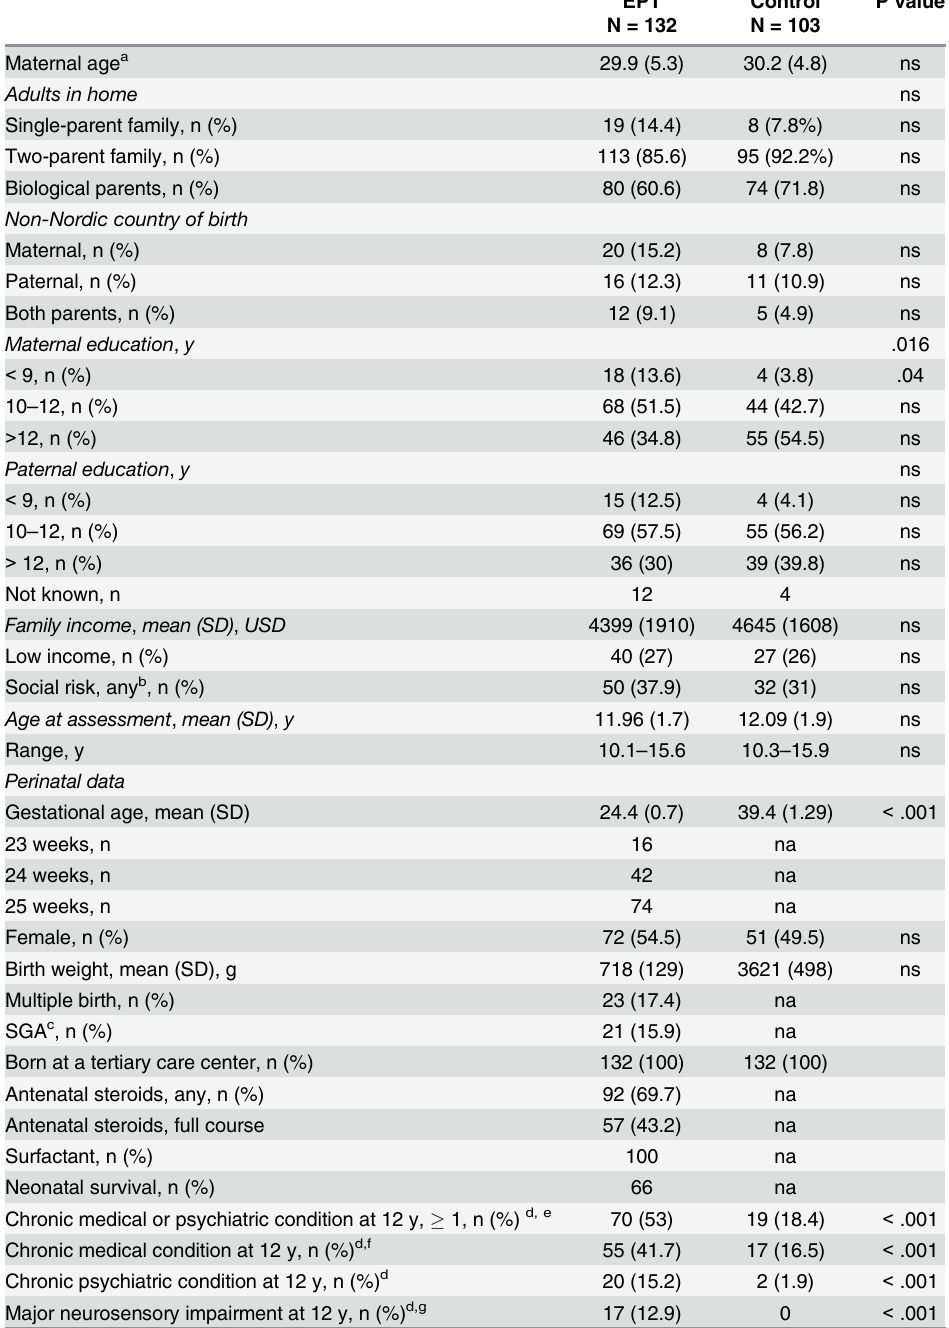
Table 1. Sociodemographic characteristics, infant birth and neonatal data and chronic conditions at 12 years of